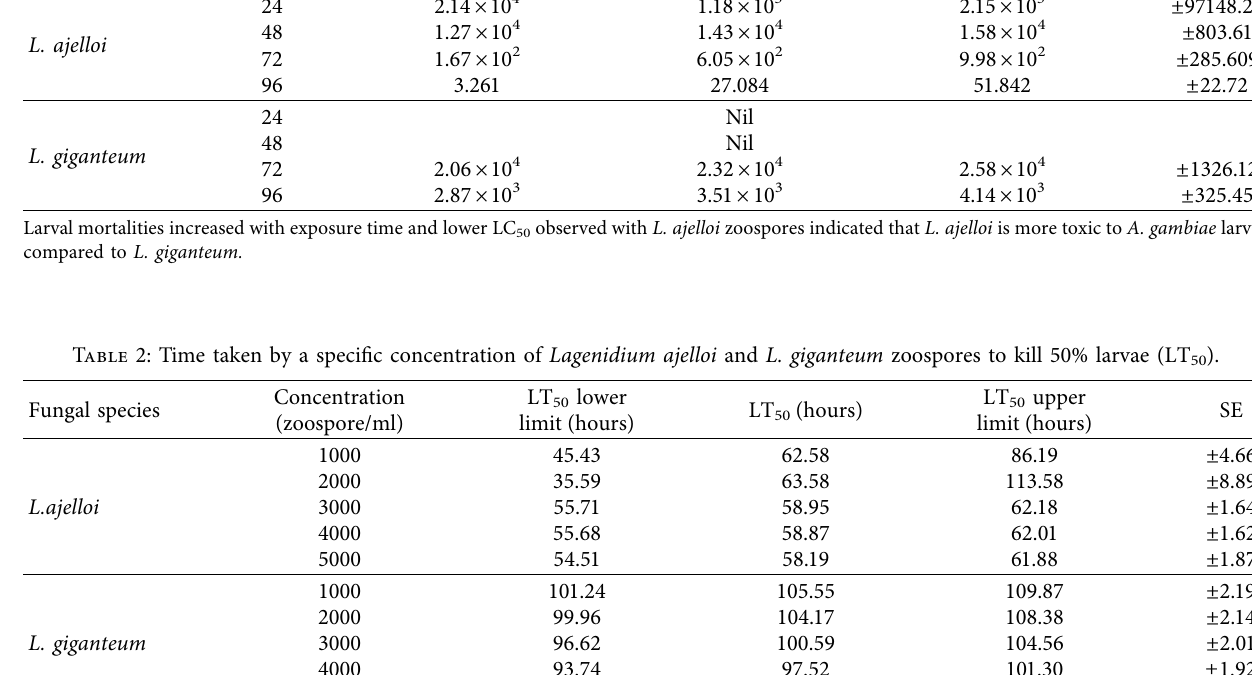
Table 1: Lower and upper limits for LC 50 of Lagenidium giganteum and L. ajelloi zoospores of the A. gambiae larvae at various time intervals. Fungal species